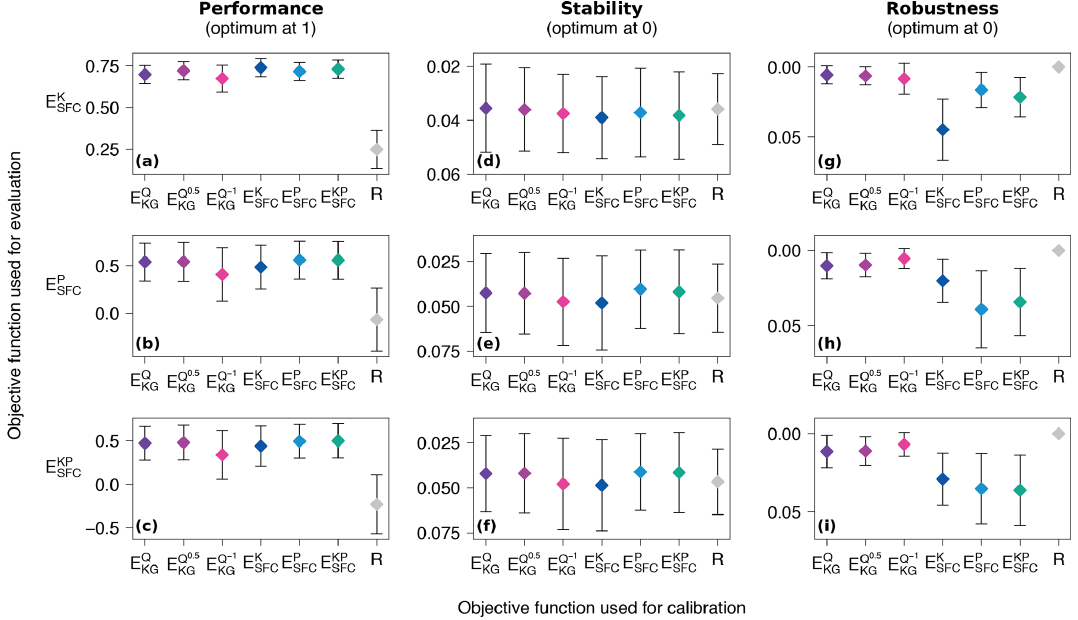
Figure 6. Comparison of the skills in evaluation of the model calibrated with the six objective functions. The first column of panels compares them on the overall performance on the three tailored objective functions used as evaluation efficiencies (described in Sect. 3.4.1). The second column compares them on the stability of these efficiencies across the 14 split-sample tests (described in Sect. 3.4.2). The third column compares them on the robustness of these efficiencies between calibration and evaluation periods (described in Sect.